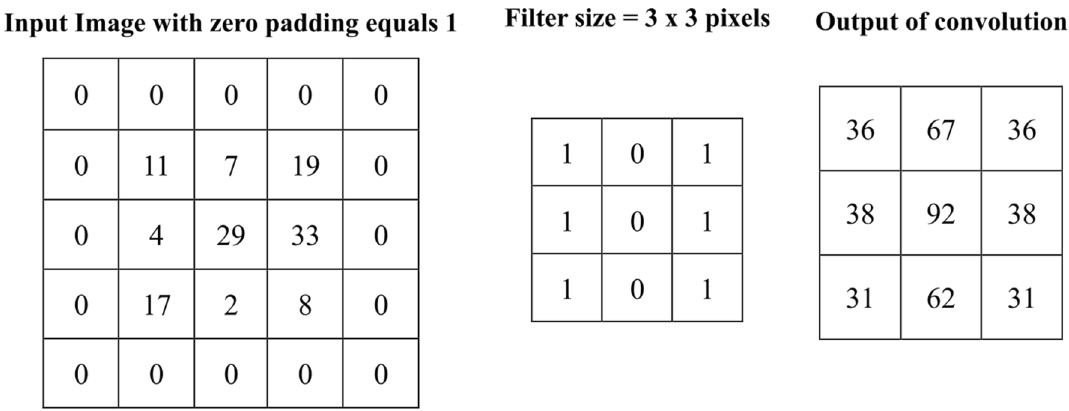
Figure 5. Example of a filter applied to a two-dimensional input image to create a feature